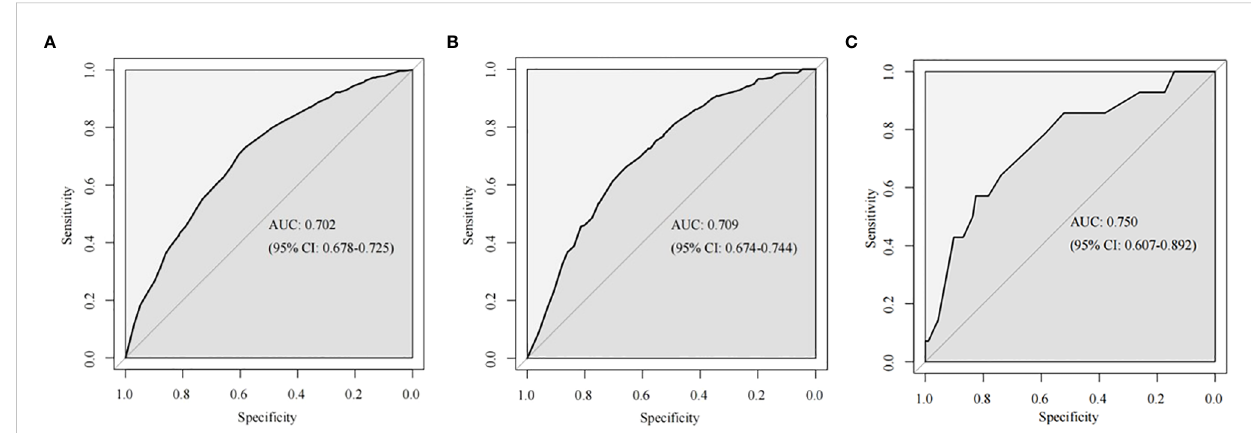
FIGURE 4 The ROC curves of the nomogram for predicting LNM in the training cohort (A) , internal validation cohort (B) and external validation (C) .